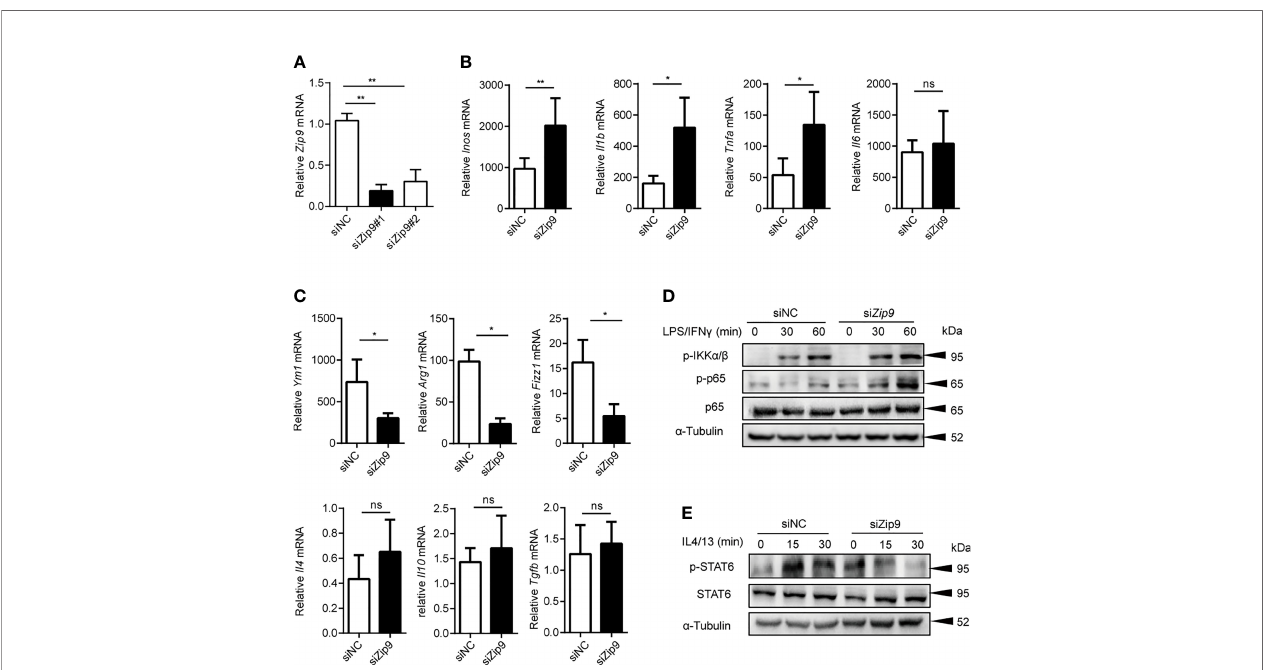
FIGURE 7 | Zip9 modulates the macrophage polarity. (A) The siRNA knockdown ef fi ciencies of Zip9 . Zip9 was analyzed by RT-PCR following transfection with Zip9 siRNA 48 hours. (B) The analysis of M1-polarized macrophages characteristic genes ( Inos , Il6 , Il1b , Tnfa ). Genes were detected by RT-PCR, following transfection with control small interfering RNA (siRNA) or Zip9 siRNA and stimulated with LPS plus IFN g . (C) The analysis of M2-polarized macrophages characteristic genes ( Ym1 , Arg1 , Fizz1 , Il10 , Il4 , Tgfb ). Genes were detected by RT-PCR, following transfection with control siRNA or Zip9 siRNA and stimulated with IL-4 and IL-13 (20 ng/ml each) * P < 0.05, ** P < 0.01 and ns, not signi fi cant. Data were analyzed by Student ’ s t-test. Results were presented as the average ± SD of at least three independent experiments. (D) PEMs were pretreated with control small interfering RNA (siRNA) or Zip9 siRNA for 48h followed by 30/60 mins stimulation with IFN g and LPS. Cell lysates were processed for immunoblotting with antibody against phospho-I k B a / b and phospho-p65 followed by stripping and reprobing with antibody against a -tubulin. (E) PEMs were pretreated with control small interfering RNA (siRNA) or Zip9 siRNA for 48h followed by 15/30 mins stimulation with IL-4 and IL-13. Cell lysates were processed for immunoblotting with antibody against phospho-STAT6 and total-STAT6 followed by stripping and reprobing with antibody against a -tubulin. Each panel is a representative experiment of at least three independent biological